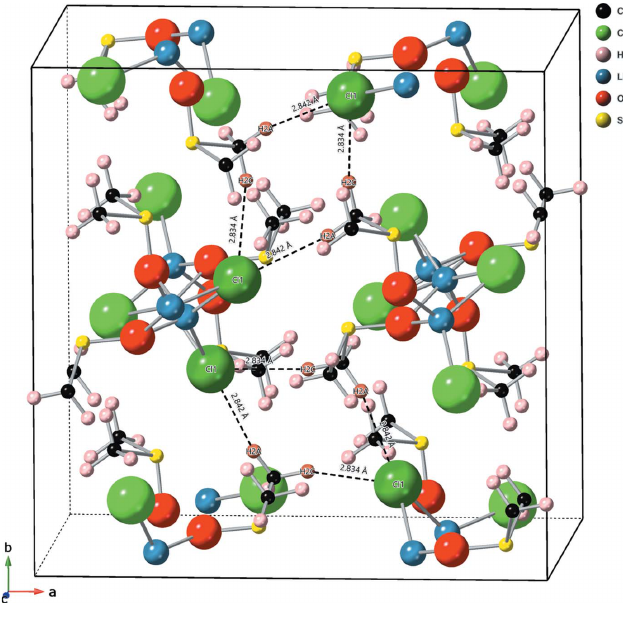
Figure 4 Tetragonal structure: packing diagram. The structure is held together by hydrogen bonding. The hydrogen bonds between Cl1 and H2 A and Cl1 and H2 C are shown. The atoms involved in hydrogen bonding are darkened for